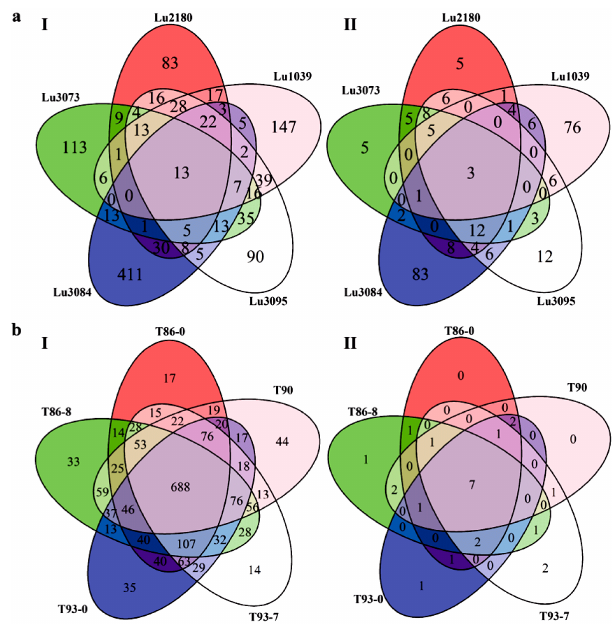
Figure 3. Venn diagrams of the bacterial and archaeal OTUs in the injection and production wells. (a) Sandstone and (b) conglomerate reservoirs. (I) Bacterial OTUs; (II) archaeal OTUs. Venn diagrams indicate the shared microbial OTUs between communities in the injected and produced water